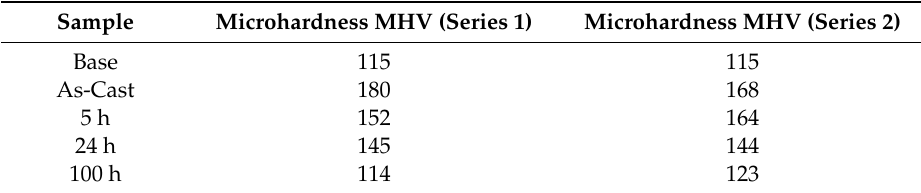
Table 5. Vickers